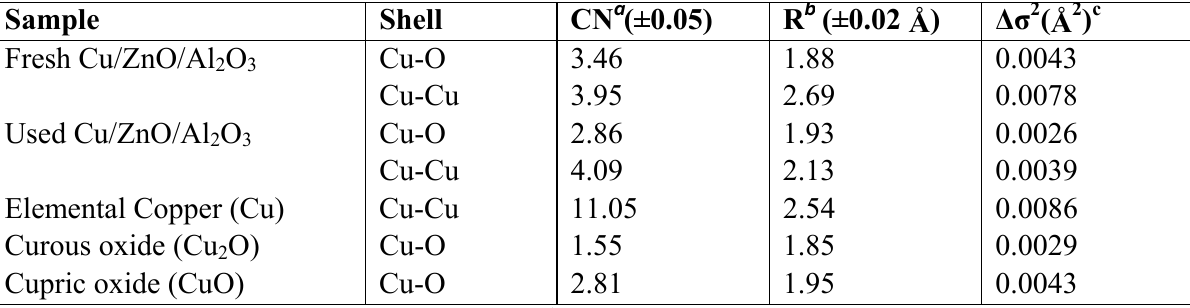
Table 4. Fine structural parameters of copper species in fresh and used Cu/ZnO/Al washcoat catalysts analyzed using EXAFS